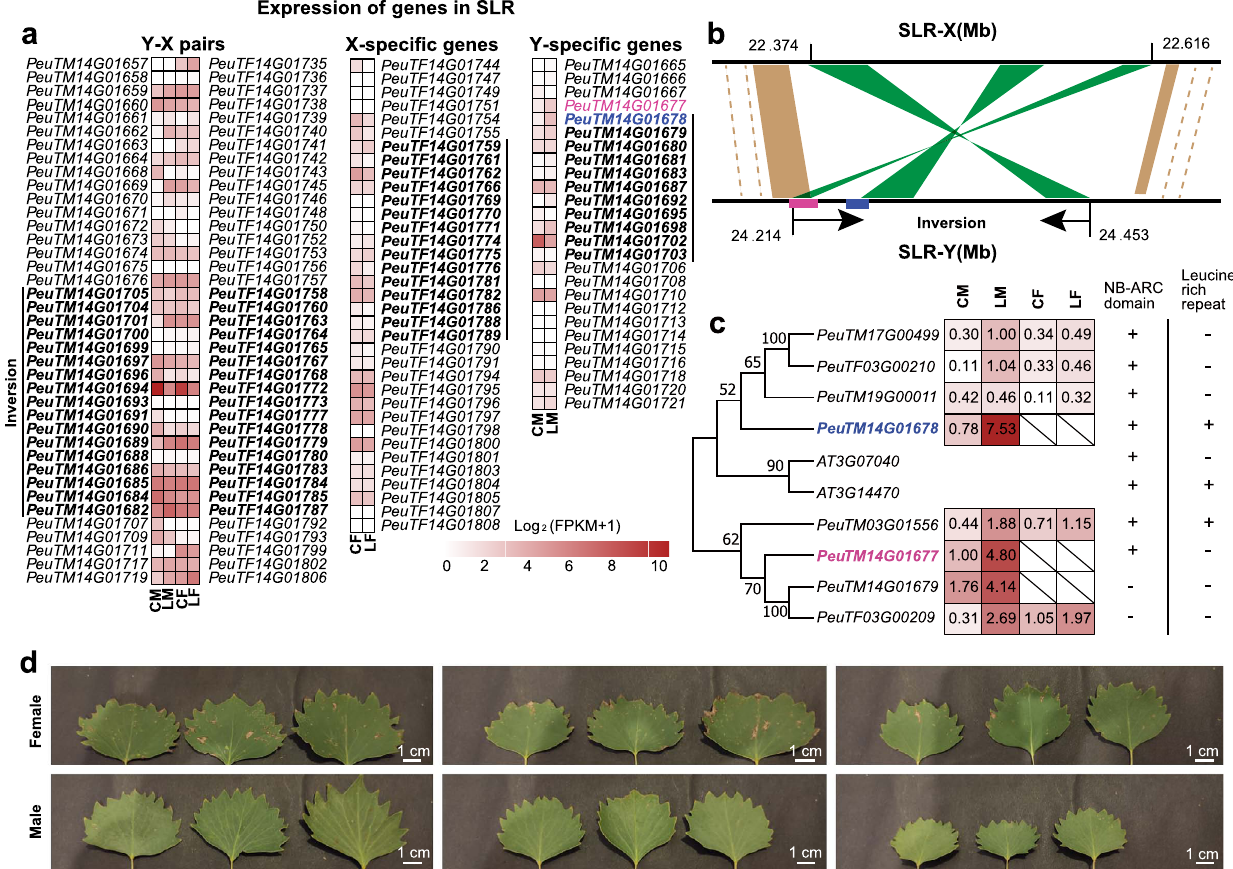
Fig. 5 Gene contents in the SLR and sexual dimorphism in resistance to disease. a Heatmap representation of gene expression for SLR-X genes and their counterparts from SLR-Y, SLR-X-speci fi c, and SLR-Y-speci fi c genes. Genes located within the inverted region are highlighted in bold. b Gene model of the fusion gene PeuTM14G01677 (red) and the neighboring gene PeuTM14G01678 (blue), RGA , in the inverted boundary between SLR-X and SLR-Y. c Phylogeny, expression levels and domains of encoded RGAs in the female and male genomes of P. euphratica . The numbers in the box represent FPKMs. For ( a , c ), CM catkin male, CF catkin female, LM leaf male, and LF leaf female. d Differential resistance of male and female leaves in response to fungal disease in three wild male and three wild female P. euphratica trees. Scale bar, 1